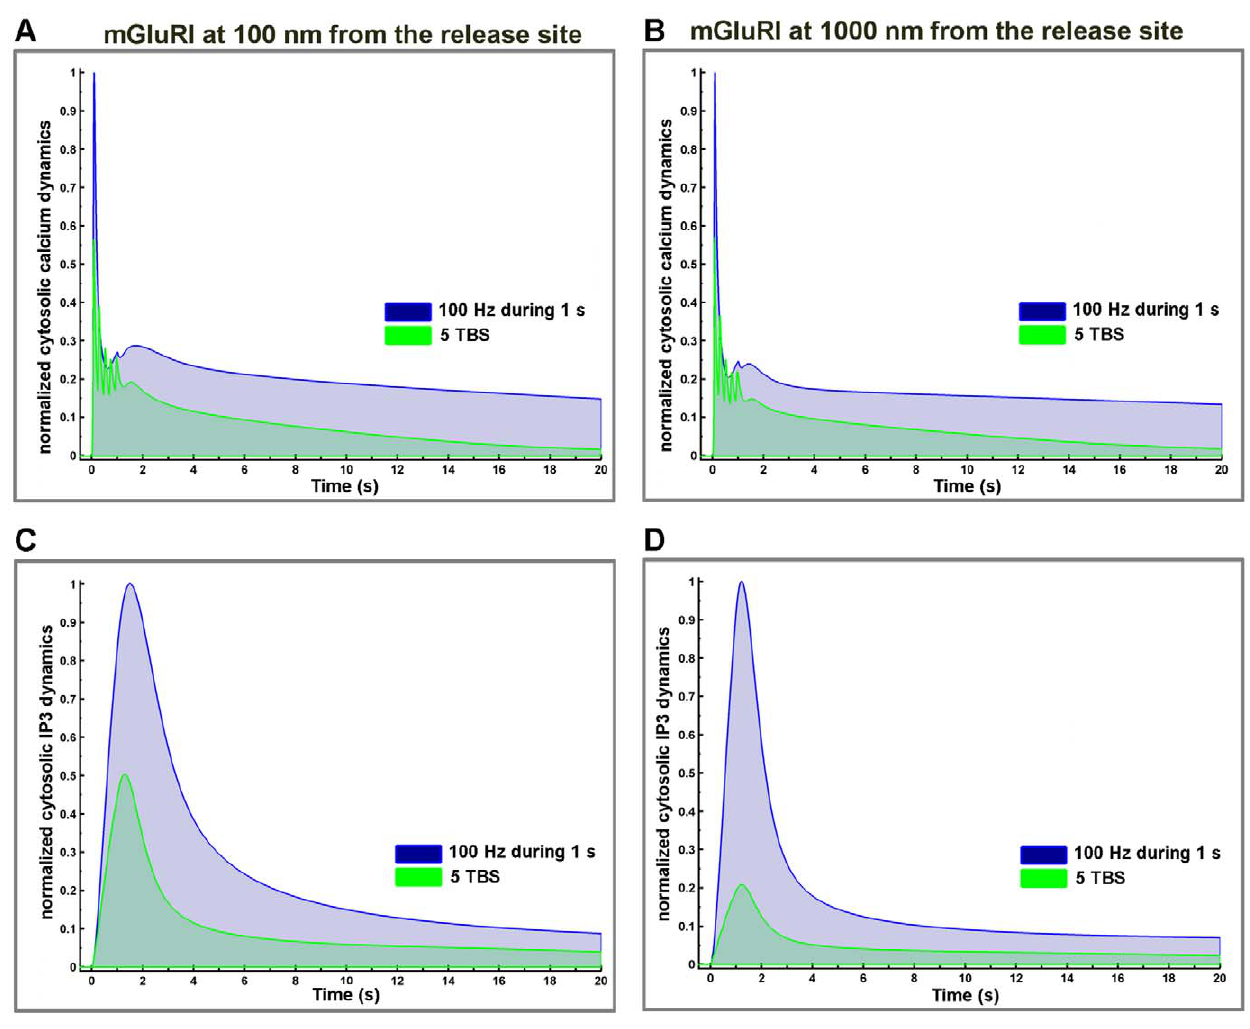
Figure 12. Comparison of the effects of tetanic stimulation vs. TBS on changes in calcium and IP3 concentration. (A, B) Temporal evolution of cytosolic calcium dynamics generated by a 1-s stimulation with 5 TBS (green line) or 100 Hz frequency (blue line) with mGluRI located at 100 nm (A) or 1000 nm (B). Values were normalized to the value observed with TBS. (C, D) Corresponding temporal evolution of cytosolic IP3 dynamics with mGluRI located at 100 nm (C) or 1000 nm (D). Values were normalized to the peak amplitude response produced by AMPA, NMDA and mGluRI receptors combined following the 100 Hz tetanic stimulation protocol for calcium (3.3 m M) and IP3 (1.4 m M).